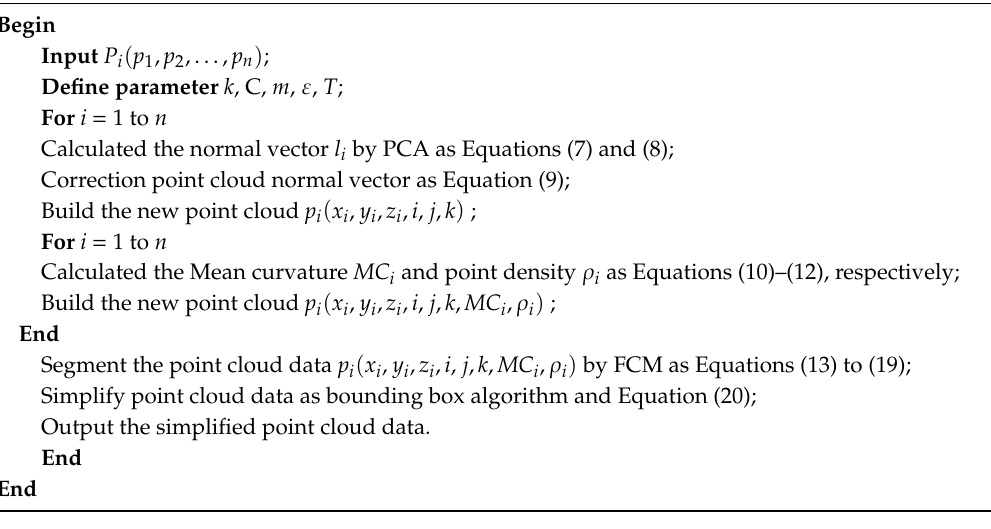
Algorithm 2 Pseudocode of Simplification